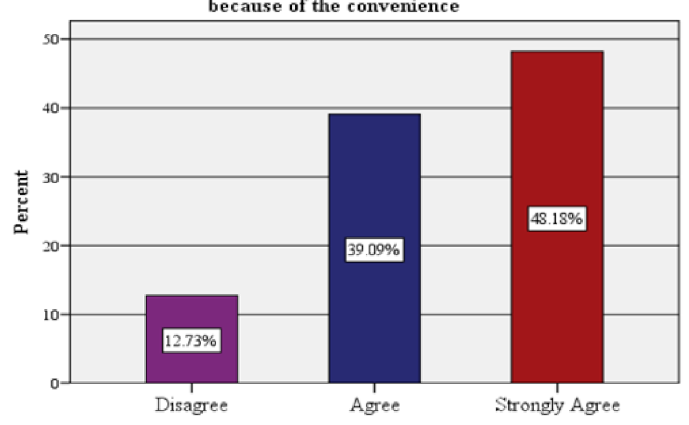
Figure 3. The convenience of mobile applications.